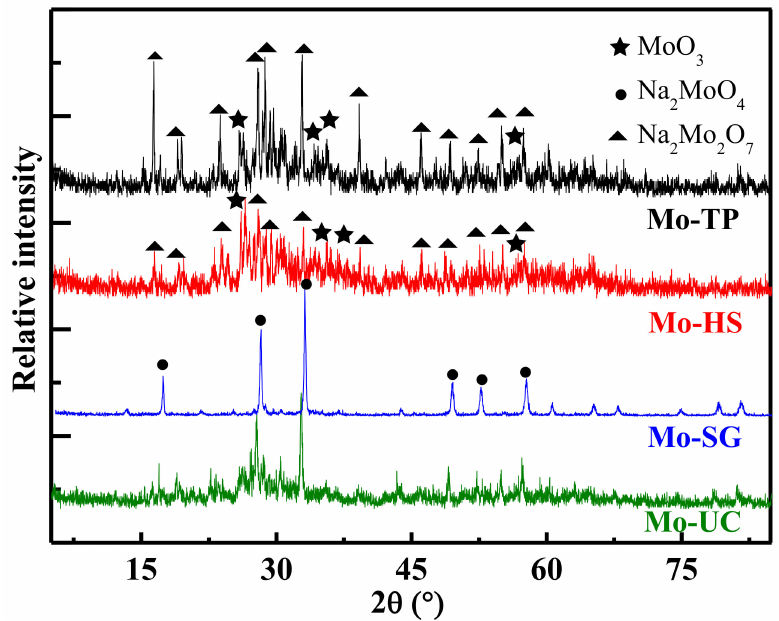
Figure 2. XRD patterns of the Mo/ZnAl-layered double hydroxide (LDH)